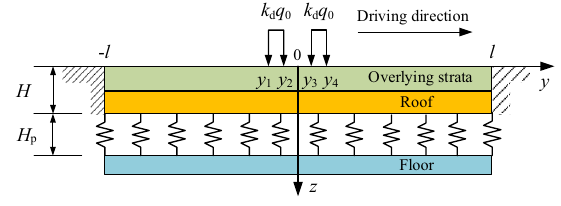
Fig. 7 Schematic diagram of the coordinate system calculated by the